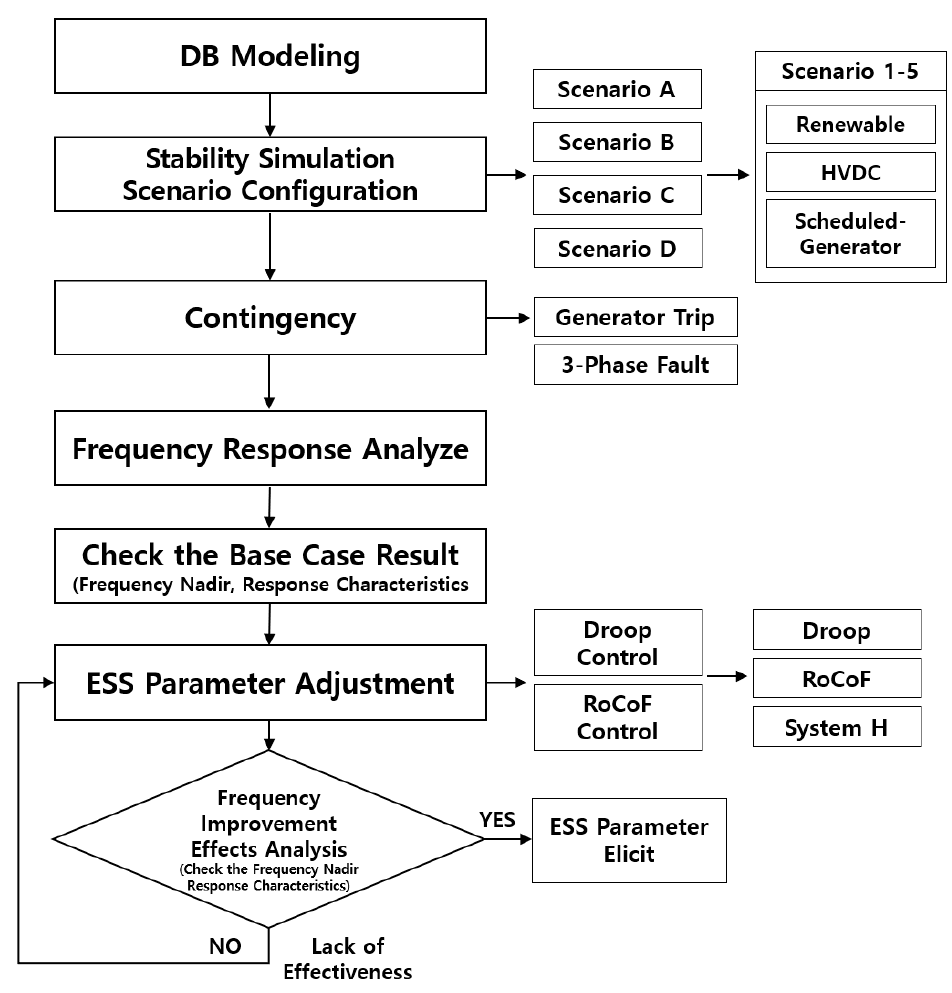
Figure 3. Simulation process.